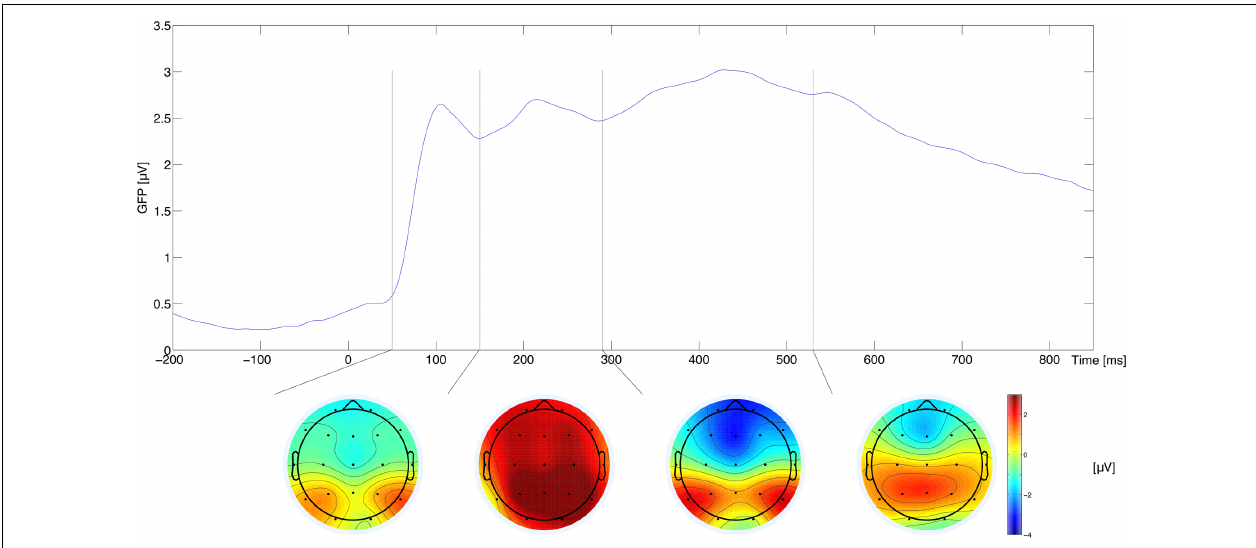
FIGURE 3 | Global field power (upper plot) and topographies of average amplitude for a given time-window (bottom plot). The vertical lines in the upper plot indicate time window boundaries.